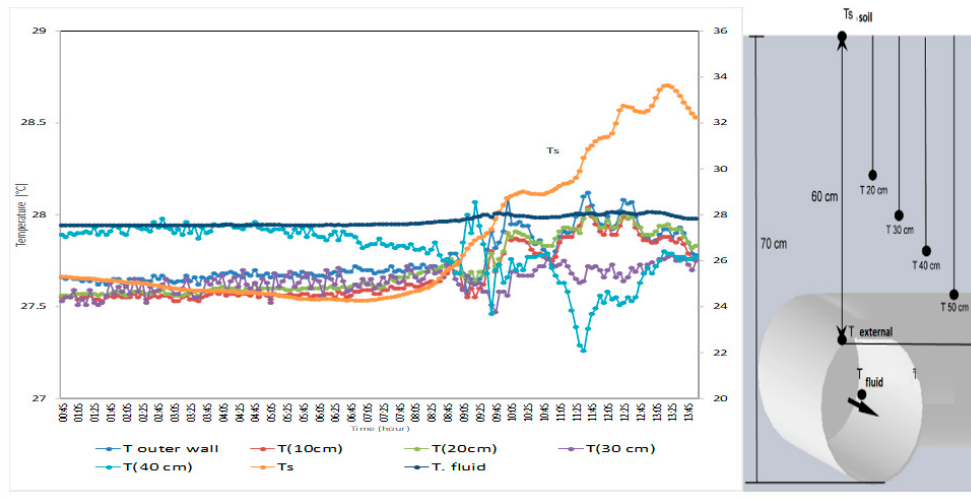
Figure 6. Soil surface temperature profile.